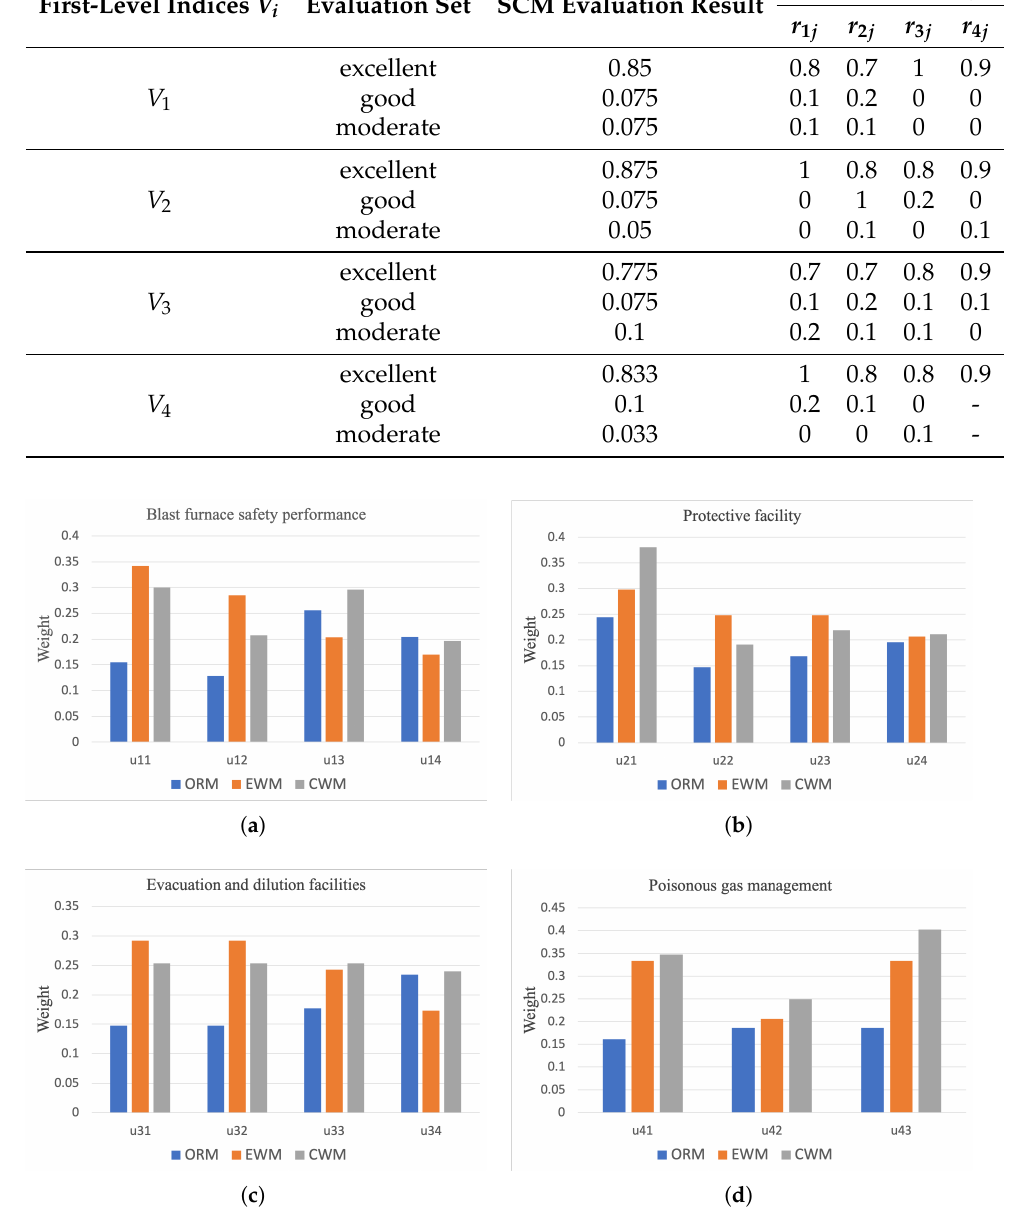
Figure 7. Comparison of ORM, EWM, and CWM weights for: ( a ) blast furnace safety performance; ( b ) the protective facility; ( c ) evacuation and dilution facilities; and ( d ) poisonous gas management. The weights calculated by CWM avoided the lack of accuracy that might occur